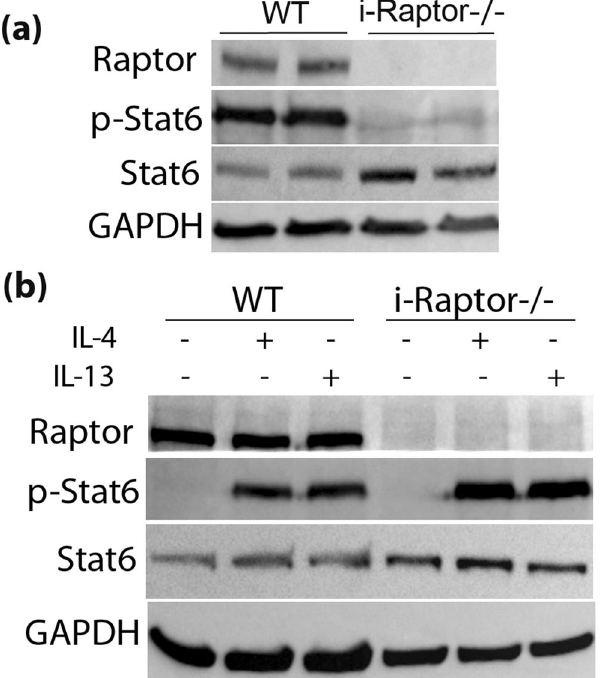
Figure 5. Raptor is dispensable for Stat 6 phosphorylation in Tm infected enterocytes. ( a ), Vilin-Cre ER ( − ); Raptor ( f / f ) (WT, n = 3) and Vilin-Cre ER ( + ); Raptor ( f / f ) ( i - Raptor − / − , n = 3) mice were injected intraperitoneally with TAM for 3 consecutive days and small intestine removed 7 days later. ( a ) Representative Western blot analysis of Stat 6 expression and phosphorylation in enterocytes. ( b ) Enterocytes were isolated from the small intestine and incubated with vehicle, 50 ng/ml IL-4 or 50 ng/ml IL-13 for 10 minutes in vitro . Stat 6 activation was analyzed via Western